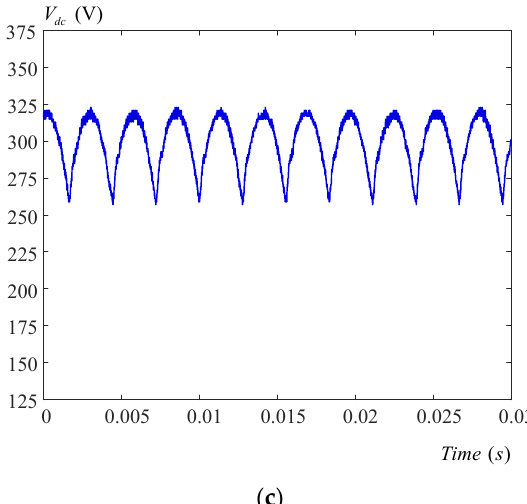
Figure 1. The matrix-converter configuration: ( a ) main circuit; ( b ) equivalent circuit; ( c ) virtual DC-link voltage.